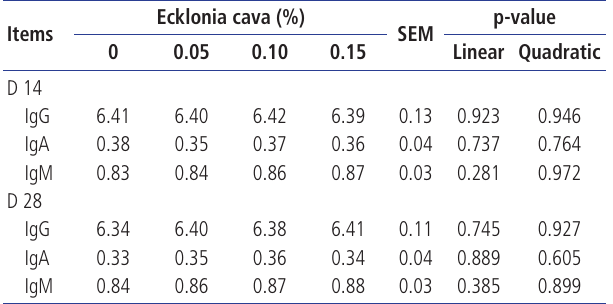
Table 6. Effects of supplemental Ecklonia cava on serum immunoglobulins (mg/mL) of weanling pigs Ecklonia cava (%) Items